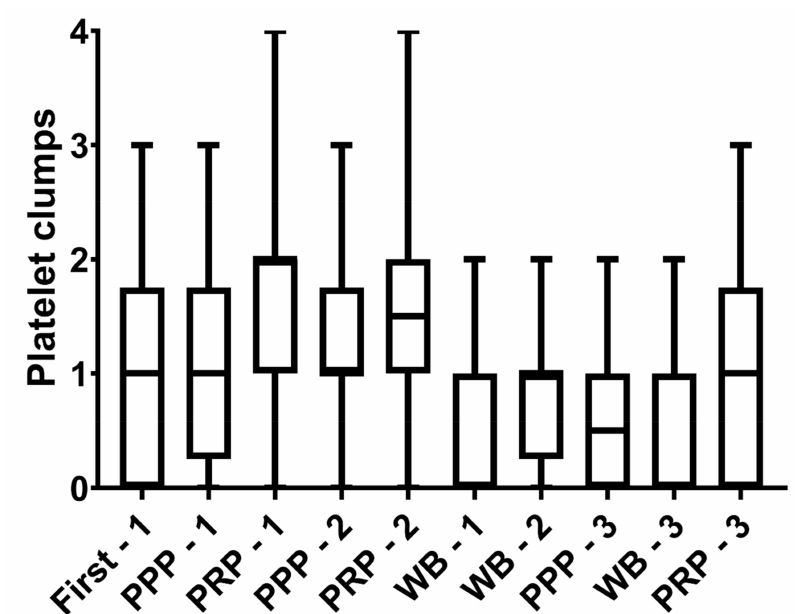
Figure 3. Assessment of platelets harvested from 18 mares by 3 methods to prepare PRP for intrauter- ine infusions in mares. Method 1 consisted of collecting whole blood (WB) in a blood transfusion bag, centrifugation of WB at 400 × g /10 min (F-C), and centrifugation of plasma at 1000 × g /10 min. Method 2 consisted of one centrifugation at 120 × g /10 min. Method 3 consisted of collecting WB in a syringe and then letting it sediment in an upright position for 4 h. After processing, PRP and PPP were obtained across methods. Platelet clumps were assessed across methods. Clumps classification: score 0, absence of platelet clumps; score 1 , small platelet clumps identified in hemocy- tometer chamber, but not within squares used to obtain platelet count; score 2 , small platelet clumps (~2–5 platelets/clumps) occurring in low numbers throughout chamber and within squares used for counting; score 3 , presence of low numbers of larger platelet clumps (~5–20 platelets/clump), or high numbers of small platelet clumps; score 4 , presence of many large platelet clumps. Table 4. Platelet, WBC, and RBC counts, and platelet viability in PRP of 6 mares, having WB harvested and processed by 3 methods to prepare PRP for intrauterine infusions in mares and cooled-stored at 5 ◦ C for up to 24 h. Method 1 consisted of collecting WB in a blood transfusion bag, centrifugation of WB at 400 × g /10 min (F-C), and centrifugation of plasma at 1000 × g /10 min. Method 2 consisted of one centrifugation at 120 × g /10 min. Method 3 consisted of collecting WB in a syringe and then letting it sediment in an upright position for 4 h. After processing (0 h), PRP was obtained across methods and cooled-stored at 5 ◦ C for 6 and 24 h. Platelet, WBC, and RBC counts, and platelet viability were assessed in fresh (0 h) and cooled-stored PRP at 6 and 24 h.